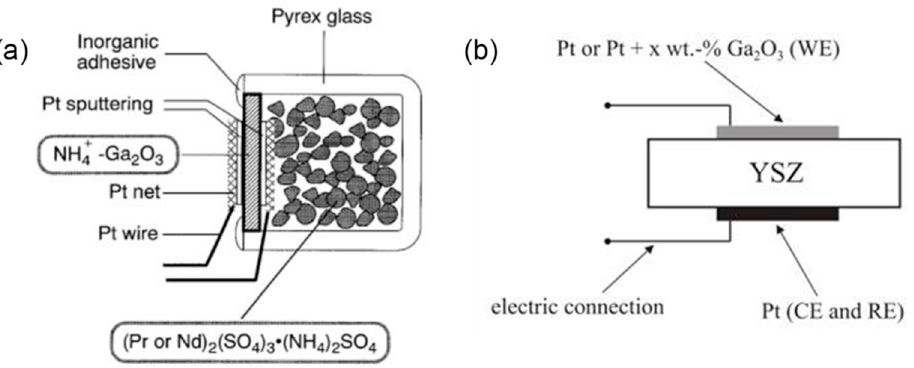
Figure 10. Schematic device structures for electrochemical gas sensors: ( a ) NH 4+ -Ga 2 O 3 solid elec- trolyte [210] Copyright 1998 The Electrochemical Society. ( b ) YSZ solid electrolyte [214]. Copyright 2004 Elsevier.